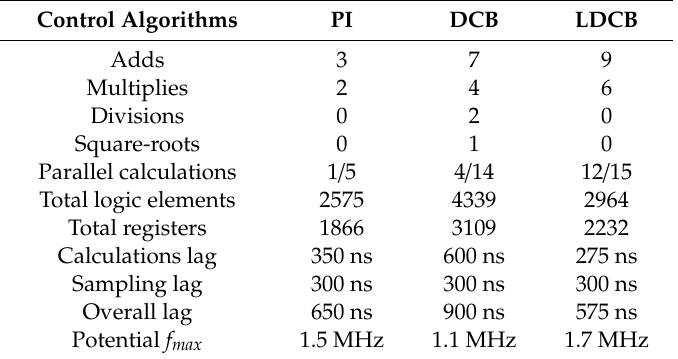
Table 3. Hardware and calculation lags of di ff erent control